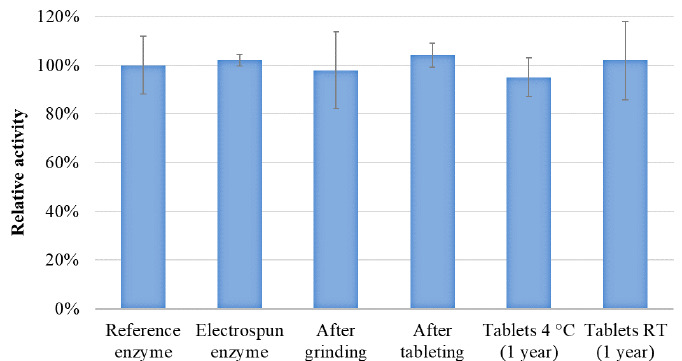
Figure 8. Enzyme activity of β -galactosidase in the fibers after high-speed electrostatic spinning (HSES), after grinding, after tableting, and the one-year stability result of the tablets (stored at 4 °C and room temperature).